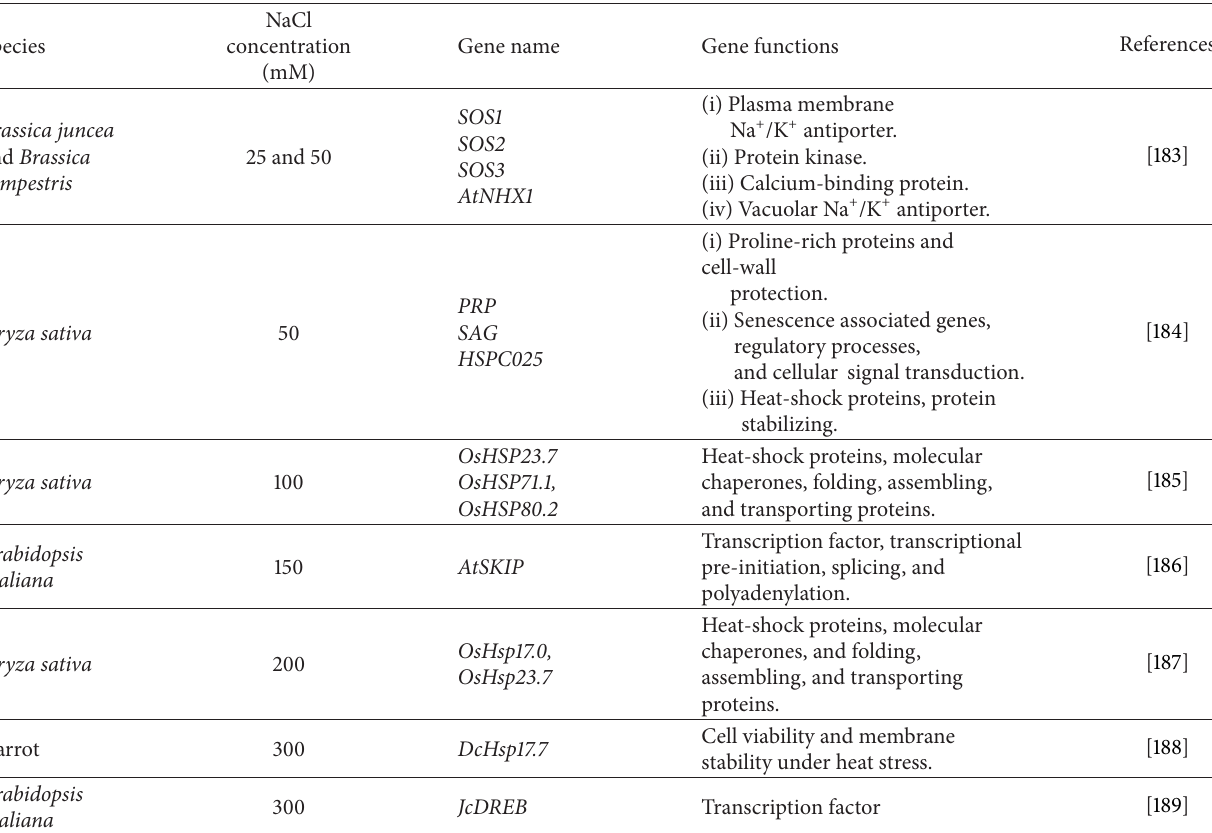
Table 1: Examples of upregulated genes in response to salinity